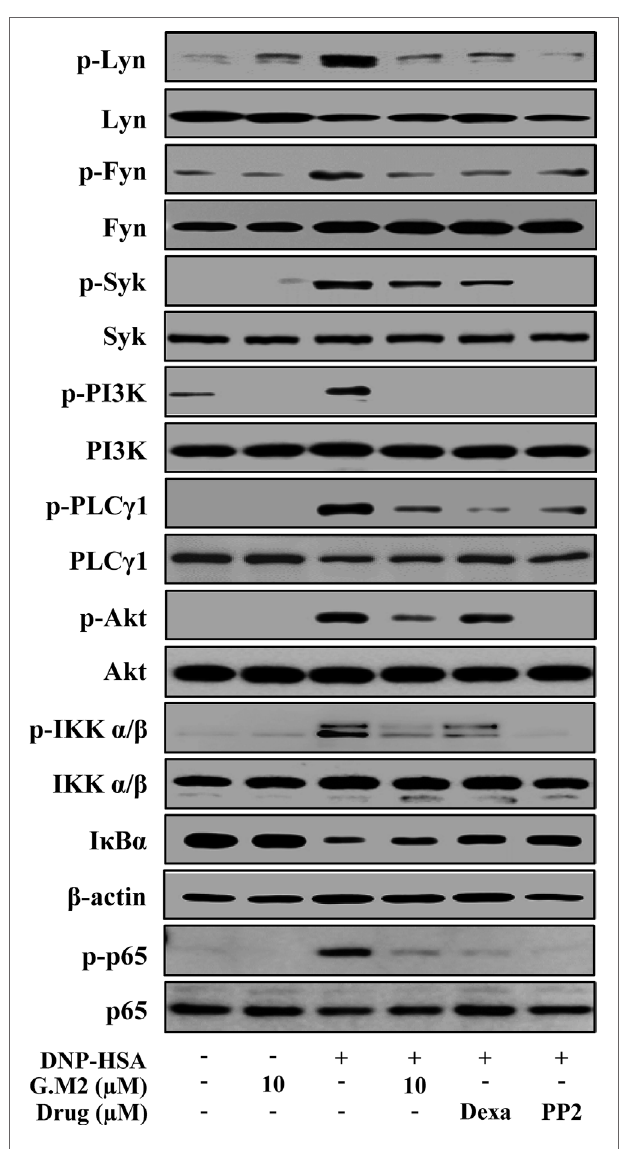
FIGURE 4 | Effects of G.M2 on Fc ε RI-mediated signaling proteins in mast cells. Anti-DNP-sensitized mBMMCs (2 × 10 6 cells/well in 6-well plates) were pre-treated with or without G.M2, Dexa, or PP2 for 1 h and then challenged with DNP-HSA (100 ng/ml). The activation of signaling proteins was assayed by Western blot analysis (p-: phosphorylated). Cropped blots are shown. Full-length blots are presented in Figure S3 . The bands of β -actin and total form were used as loading controls. Each blot is a representative of three independent